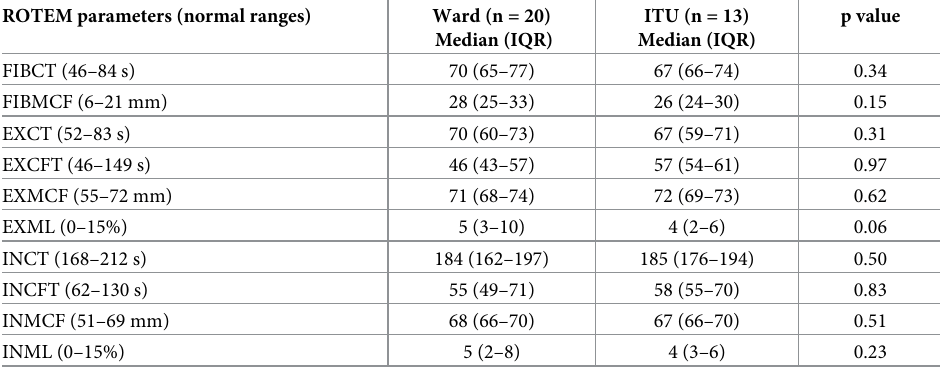
Table 2. ROTEM parameters between those admitted to ward and ITU. The median values on admission are pre- sented in the table. ROTEM parameters (normal ranges)